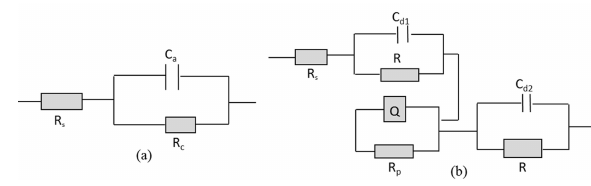
Figure 4: Equivalent circuits of the Bode plots (a) early stage (b) middle stage